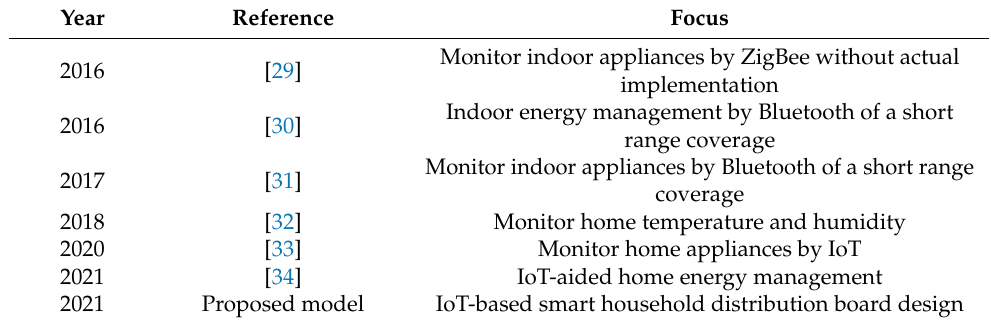
Table 1. Survey on literature